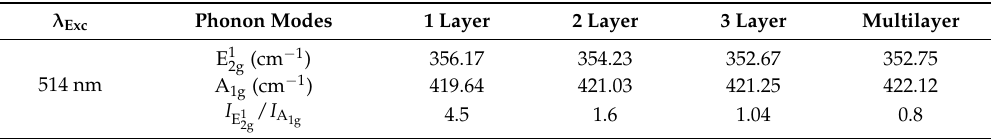
Figure 5. ( a ) Raman spectra with different WS 2 thicknesses; ( b ) frequency change of A 1g and E 1 with different thicknesses; ( c ) I / I A ratio with different layers. Table 1. Summary of the peak frequency for A 1g and E 1 and the intensity ratio of the two peaks as a function of thickness with the excitation wavelength 514 nm.